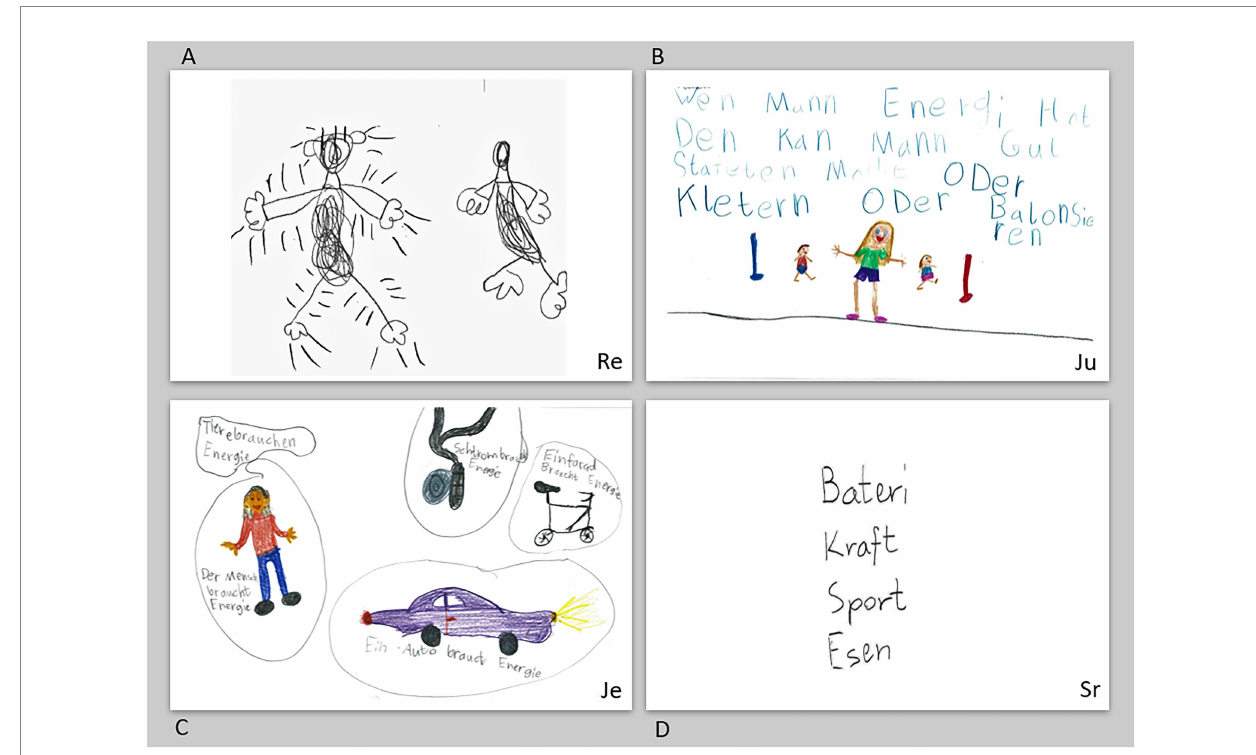
FIGURE 2 Four drawings/notes of associations with energy that (partly) refer to human beings. A : drawing only, B & C : drawing and text, D : text